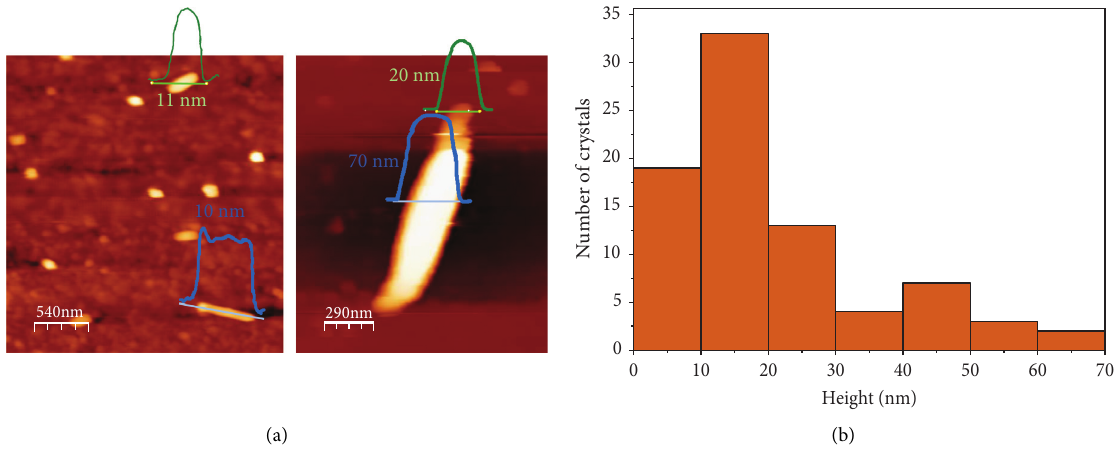
Figure 4: AFM images of compound 1n (a) and statistical histogram of height